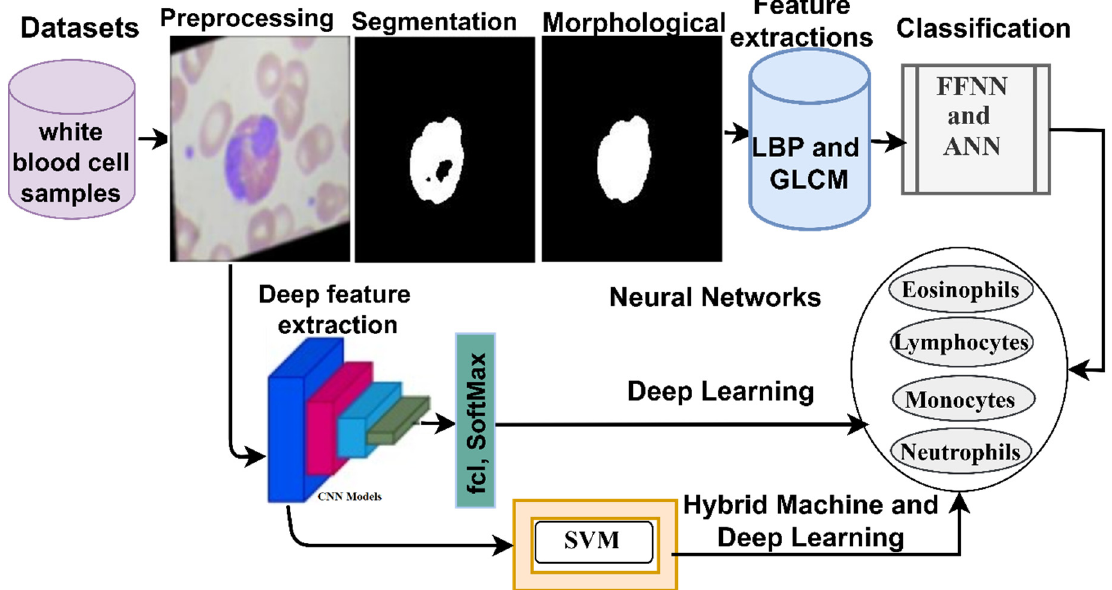
Figure 1. Morphology for diagnosing the WBC sample datasets.